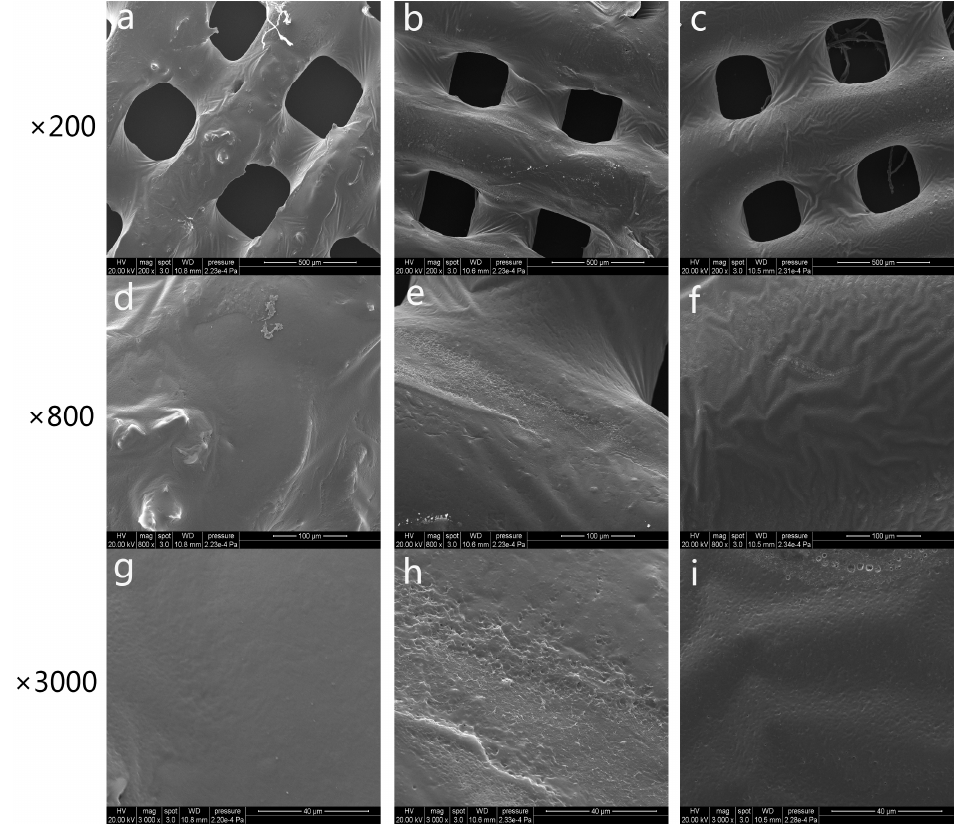
Figure 3. Scanning electron microscope (SEM) microphotographs of freeze-dried platelet-rich plasma polycaprolactone (PRP-PCL) scaffolds ( a , d , g ), traditional PRP-PCL scaffolds ( b , e , h ), and bare PCL scaffolds ( c , f , i ) at ×200, ×800, and ×3000 magnification. PRP could be seen after coating with freeze-dried PRP-PCL scaffolds ( a , d , g ) or traditional PRP-PCL scaffolds ( b , e , h ). Randomly distributed PRP are visible around the surface of the scaffolds, while no PRP are visible on the bare PCL scaffolds ( c , f , i ).